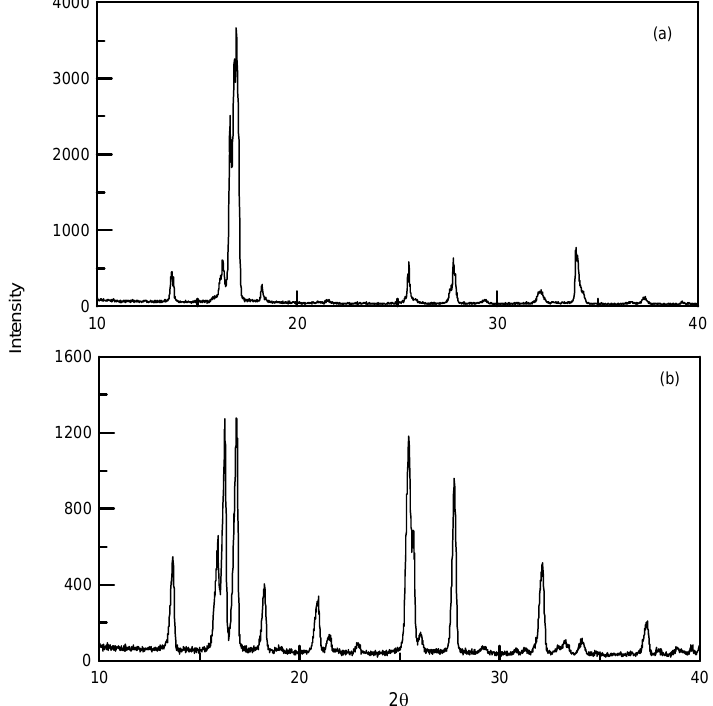
Figure 5. PXRD results of salicylamide: ( a ) original crystals and ( b ) salicylamide crystals obtained in Experiment 1.